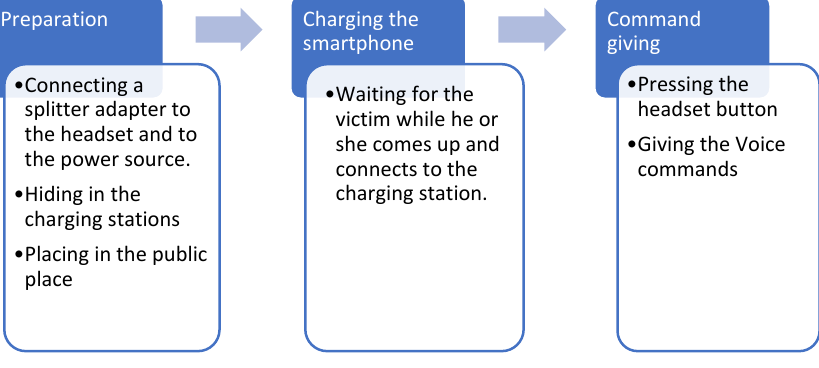
Figure 14. The attack flow.